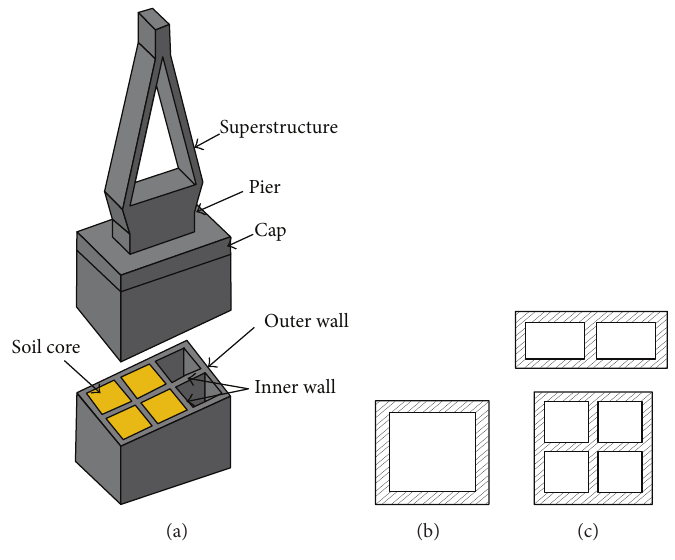
Figure 1: Structural layout of LSDW.